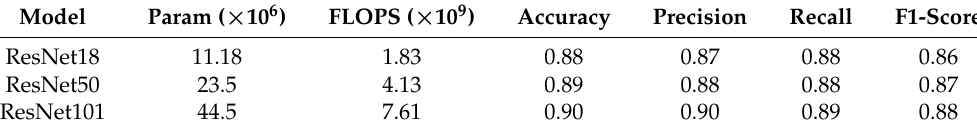
Table 2. Training results for three variants of ResNet.